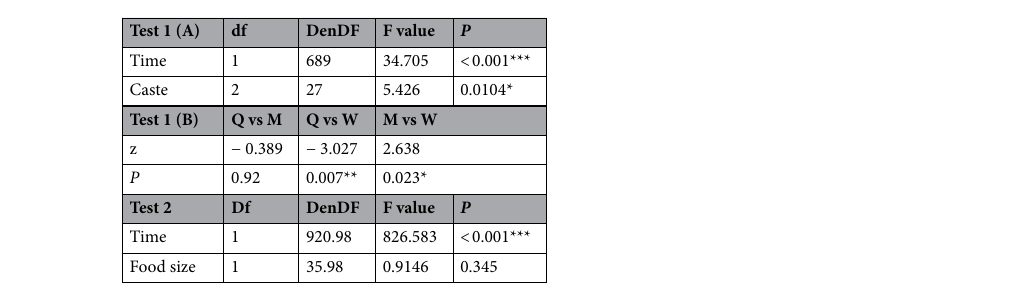
Table 3. Results of mixed models for the chirp repetition, both for Test 1 and Test 2. Test 1-A and Test 2: type III ANOVA with Satterthwite’s method, Test 1-B: multiple comparisons between castes in pair (Tukey contrasts). Asterisks indicate the level of significance (*< 0.05; **< 0.01). Q queens, M males, W workers, df and DenDF are the two freedom degrees of the